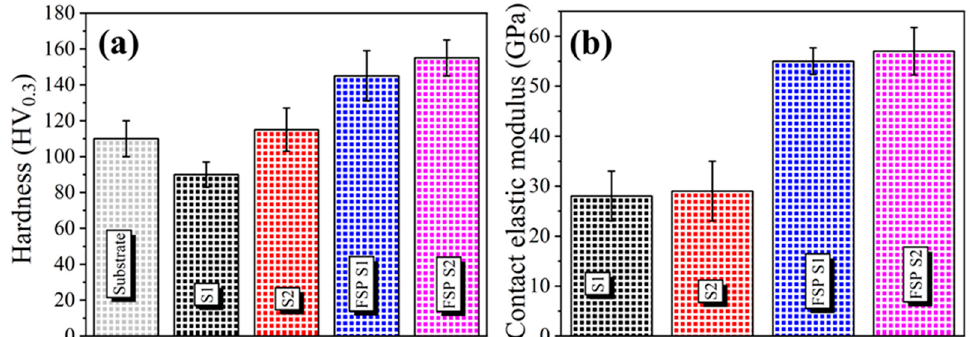
Figure 10. Mechanical properties of the as-sprayed and friction stir processed coatings ( a ) hardness, ( b ) contact elastic modulus.